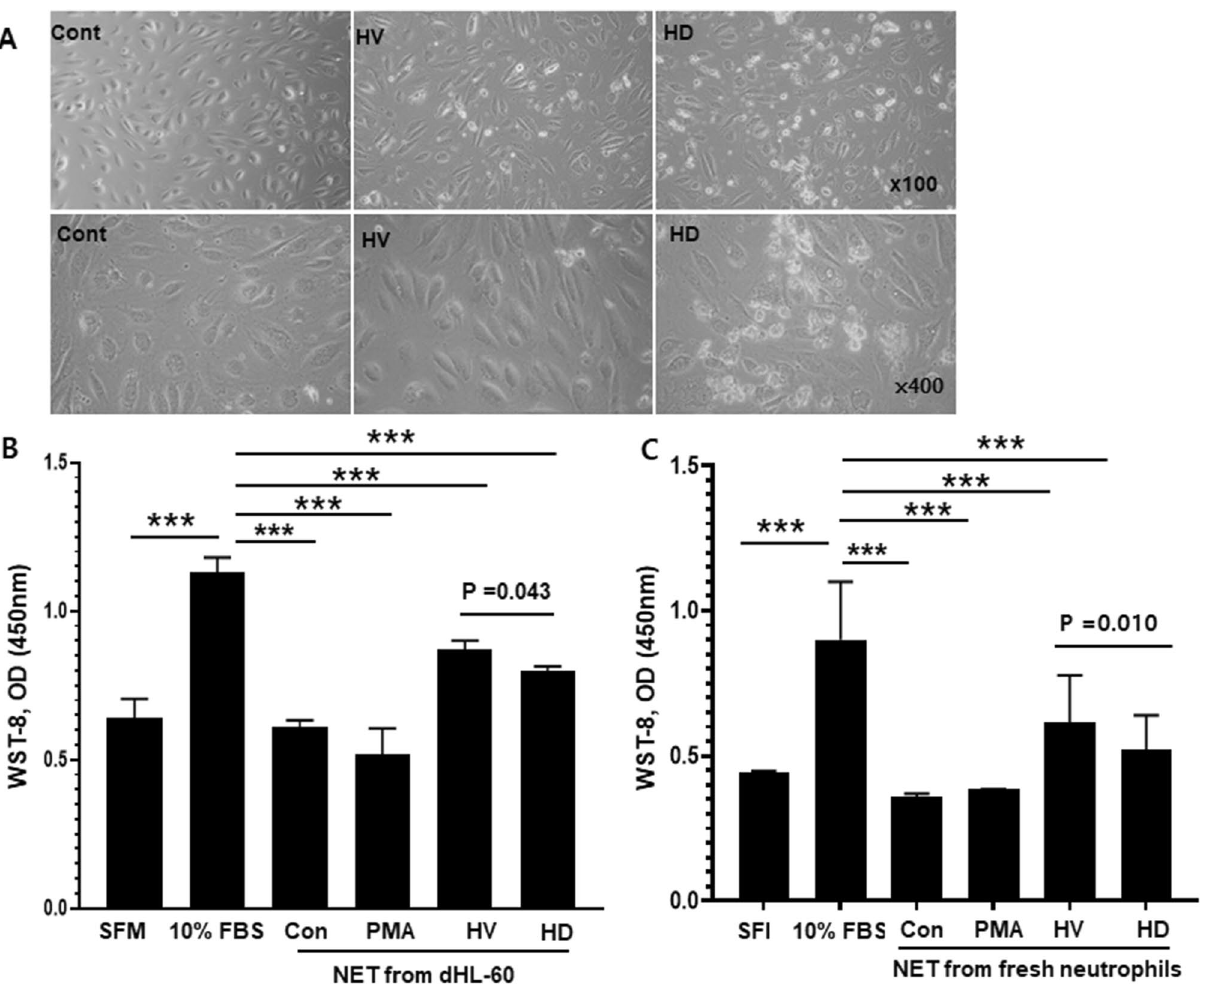
Figure 6. Damage to endothelial cells by NETs. To assess HUVEC damage, control (0 nM PMA), 400 nM PMA, HV serum, and HD serum were applied to dHL-60 cells for 17 h. Supernatants (10%) were added to HUVECs and incubated for 20 h. Serum-free medium (SFM) and 10% FBS were used as controls. ( A ) Morphology of HUVECs. In HV and HD NETs, cells became elongated compared to the control, and many dead floating cells were observed (magnification, upper panels, ×100; lower panels, ×400). ( B ) Effect of NETs from dHL-60 cells on HUVEC viability was tested by WST-8 assay. HUVEC viability was higher in HV